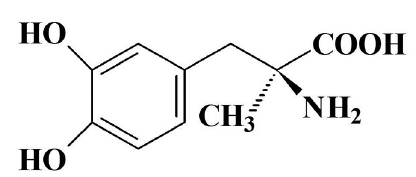
FIGURE 2 - Chemical structure of